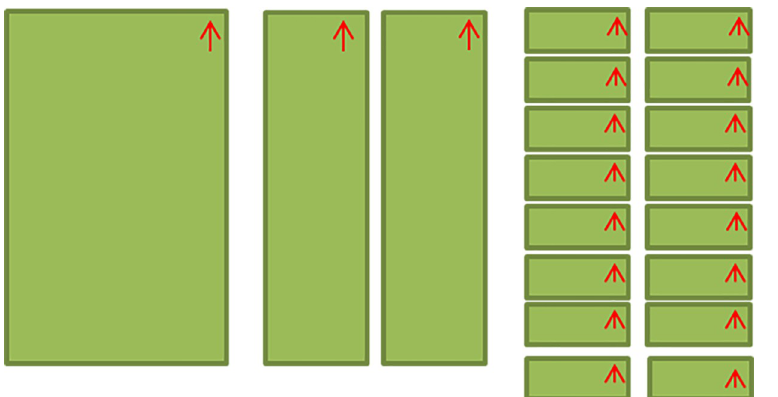
Fig 1. A diagram outlining the film cutting and orientation indicating process for a single sheet.